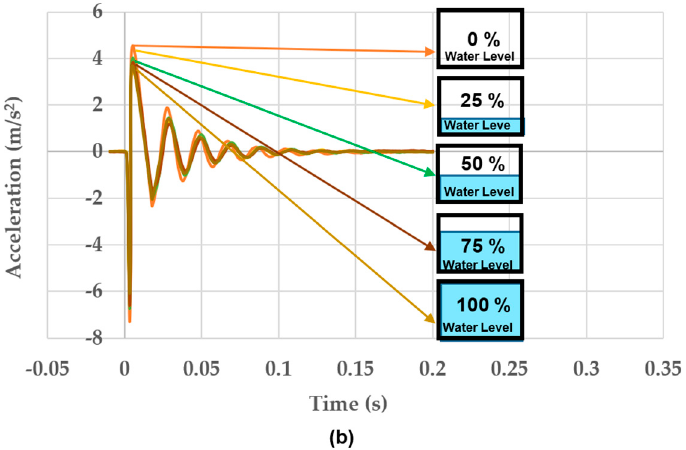
Figure 12. ( a ). Change of impulse, ( b ) change of acceleration under various water levels.